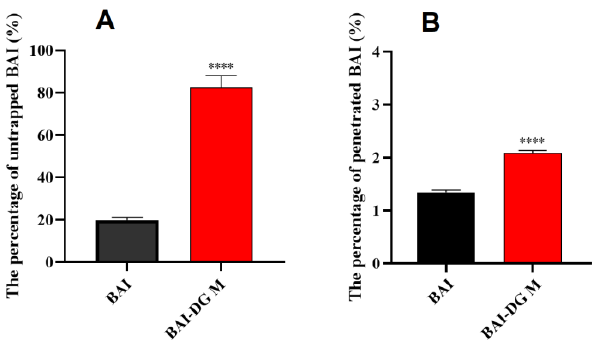
Figure 9. ( A ) Percentage of BAI untrapped by mucus; ( B ) rate of BAI permeation across the mucus layer. **** p < 0.001 compared with the BAI